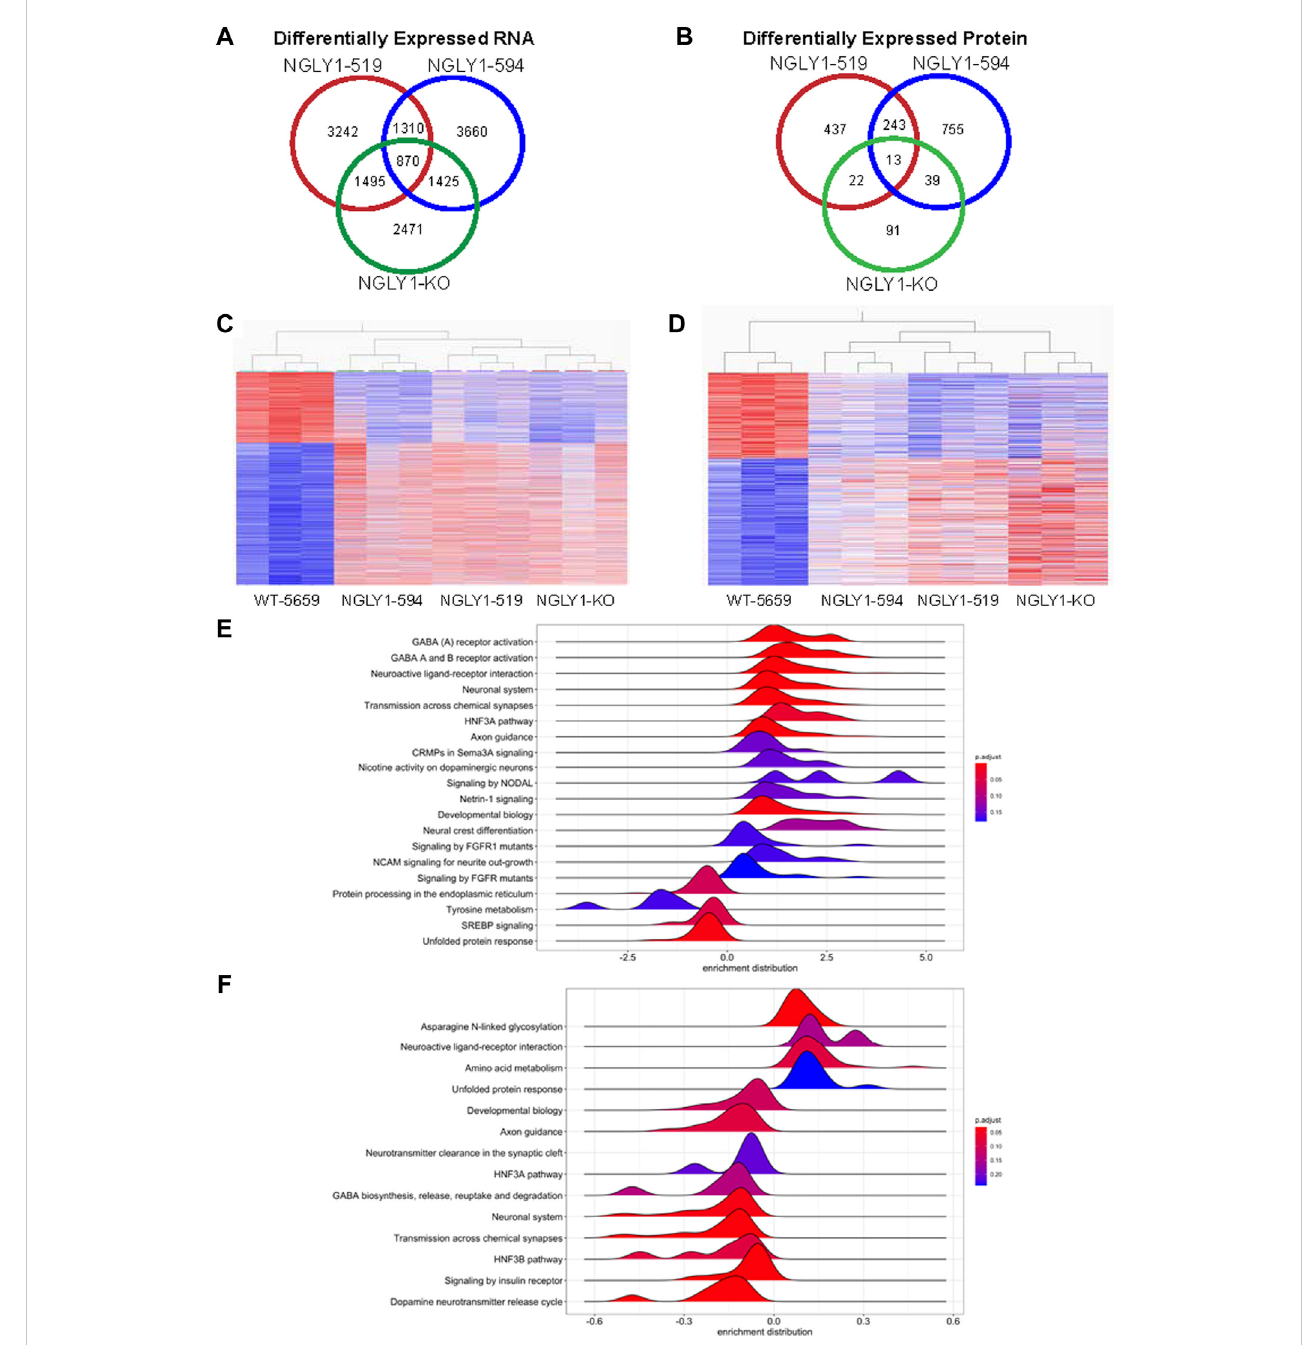
FIGURE 7 MultiomicanalysisofNGLY1de fi cientmidbrainorganoids. (A) Venndiagramsummaryofdifferentiallyexpressedgenesinmidbrainorganoids,differential expression was de fi ned as absolute value log-2 fold-change > 1 with a FDR < 0.01. (B) Venn diagram summary of differentially expressed proteins in midbrain organoids,differentialexpressionwasde fi nedasabsolutevaluefold-change > |25%|withaFDR < 0.05. (C) Heatmapshowingupregulatedanddownregulated transcripts in NGLY1 de fi cient midbrain organoids. Expression normalized to wild type, red corresponds to higher expression, blue represents lower expression. (D) Heatmap showing upregulated and downregulated proteins in NGLY1 de fi cient midbrain organoids. Expression normalized to wild type, red corresponds to higher expression, and blue represents lowered expression. (E) Gene set enrichment analysis of global transcriptomic analysis of NGLY1 de fi cientmidbrainorganoidsusingtheNCATSBioPlanetpathwayannotation,pathwayswithanFDR < 0.20wereincluded. (F) Genesetenrichmentanalysisof proteomic pro fi ling of NGLY1 de fi cient midbrain organoids utilizing the NCATS BioPlanet pathway database, pathways with an FDR < 0.25 were included.